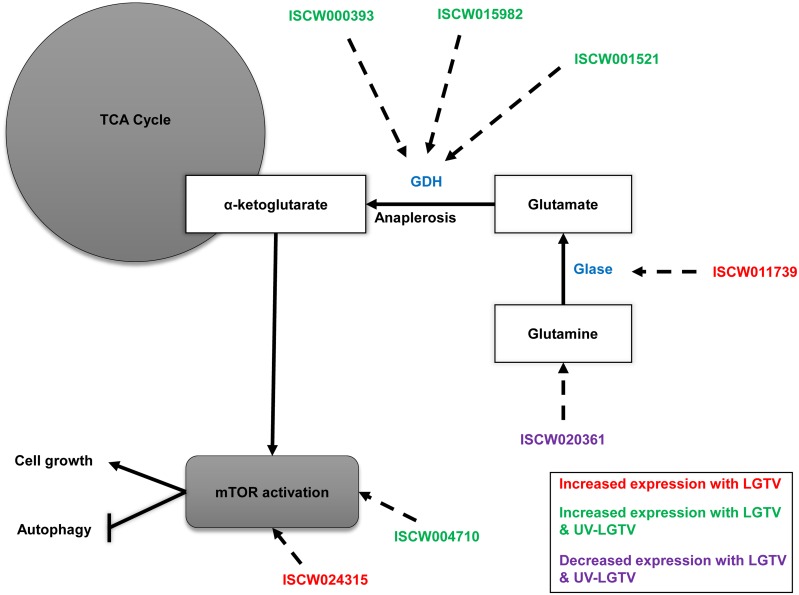
ISE6 proteins associated with the TCA cycle and glutaminolysis.ISE6 glutaminolysis and mTOR signaling proteins altered with LGTV infection are shown. GDH denotes glutamate dehydrogenase enzymes and Glase denotes glutaminase enzymes. ISCWxxxxxx denotes corresponding VB accession ID for corresponding I. scapularis protein.